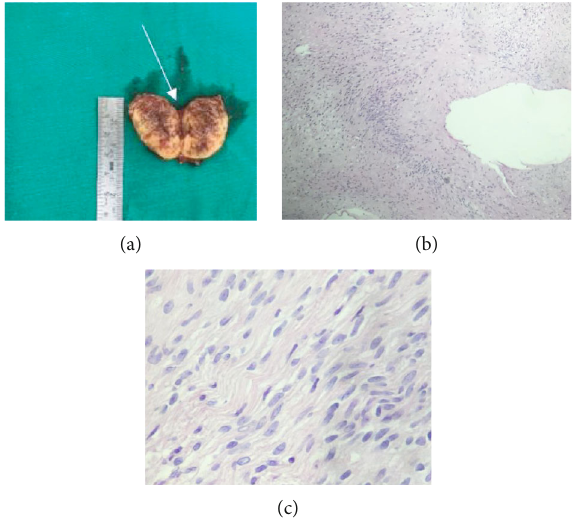
Figure 2: Images of postoperative pathologies: (a) gross picture; (b) HE × 50 and HE × 400, tumors with a dense cellularity and a small cystic degeneration areas; tumor cells were spindle-shaped and quite uniform and have fi ne chromatine, unknown nucleoli, no abnormalities, and poor mitoses. (c) The tumor cells have an unknown cytoplasmic boundary, arranged in parallel bands, suggesting a